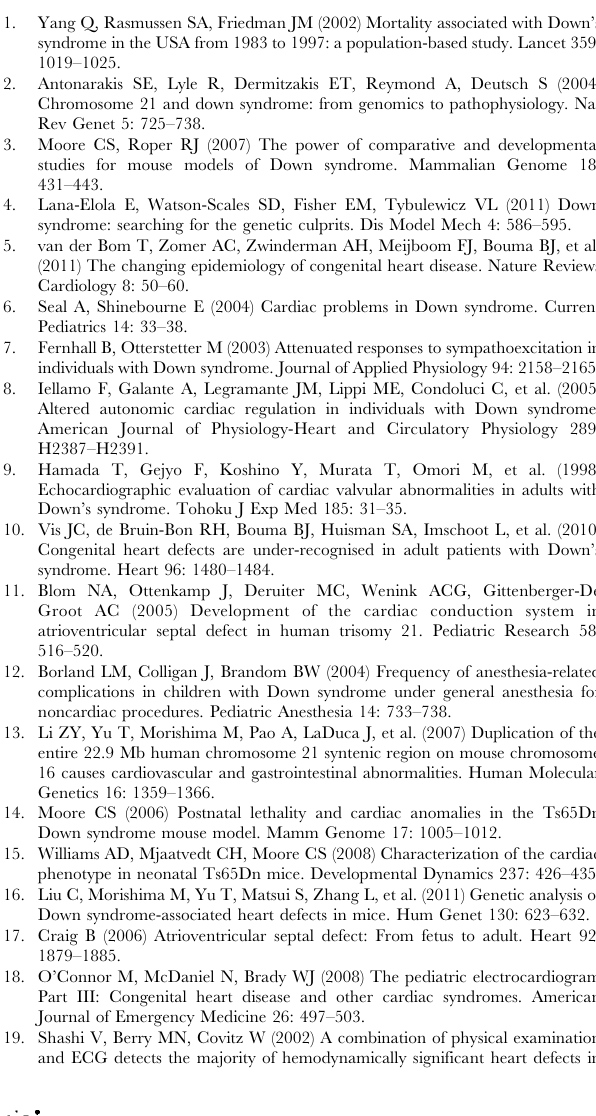
down-regulated gene with a ratio , 0.8 are in green. Normal expression ration between 0.8 and 1.2 are underlined in grey. Table S2 Sequences and Tm of primers and Taqman probes used for qPCR analyses. Genes in bold were used as